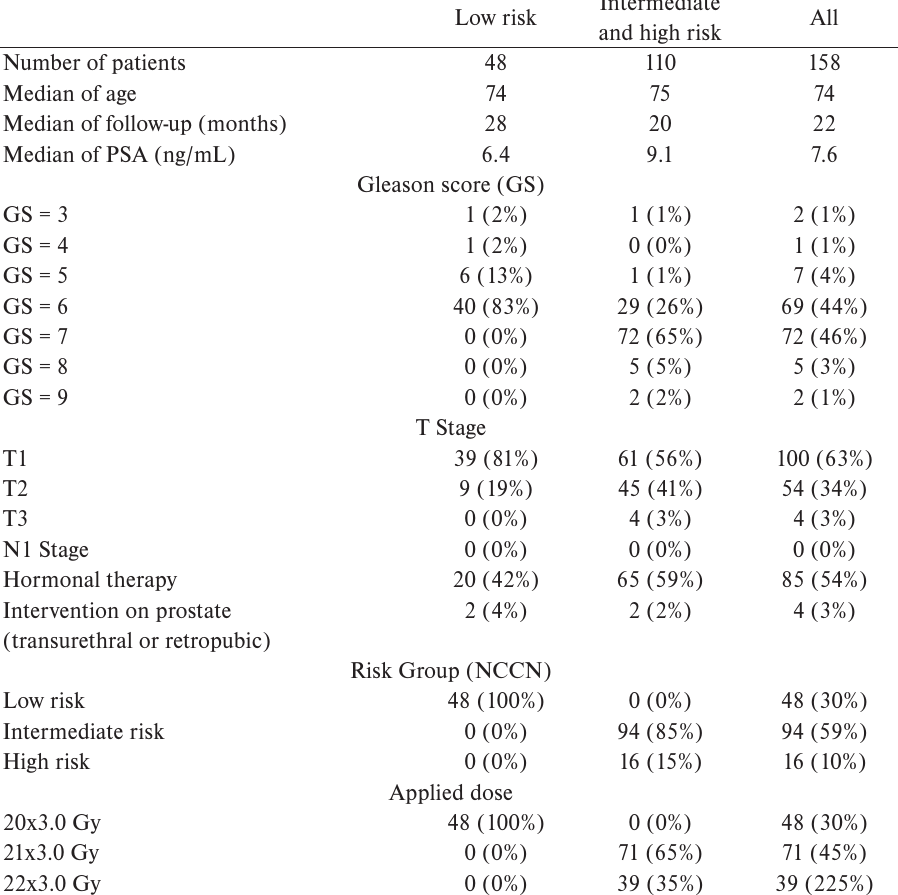
Table 1. patient’s